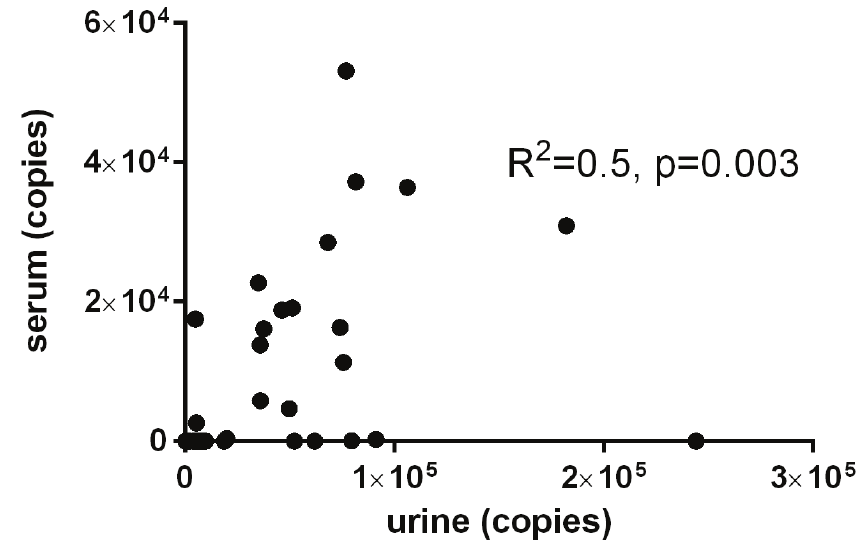
Figure 5. Correlation of miR-224 in the serum and urine of a matched cohort of HNF1A-MODY mutation carriers ( n = 30) and normal controls ( n = 8). Spearman correlation analyses demonstrated a significant correlation between serum and urine for miR-224 ( R 2 = 0.5, p <